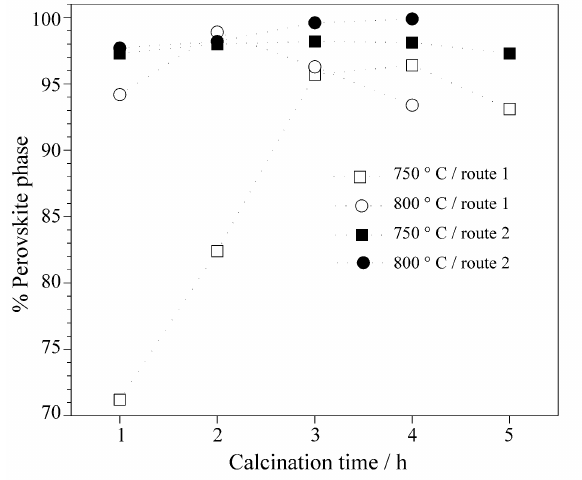
Figure 5. X-ray pattern for PMN powders prepared by route 2, calcined at 750 °C for: a) 1 h, b) 2 h, c) 3 h, d) 4 h, e) 5 h.